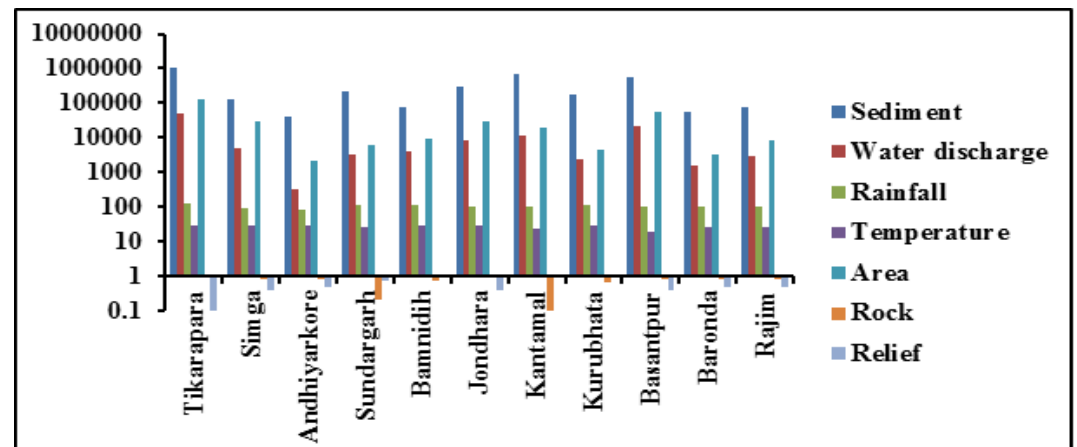
Figure 3. Spatial variation of monthly average hydro-climatic and geomorphological data such as water discharge (cms) (m 3 /s), temperature ( ℃ ), rainfall (mm) and sediment load (t/ month), relief (m), and catchment area (km 2 ).